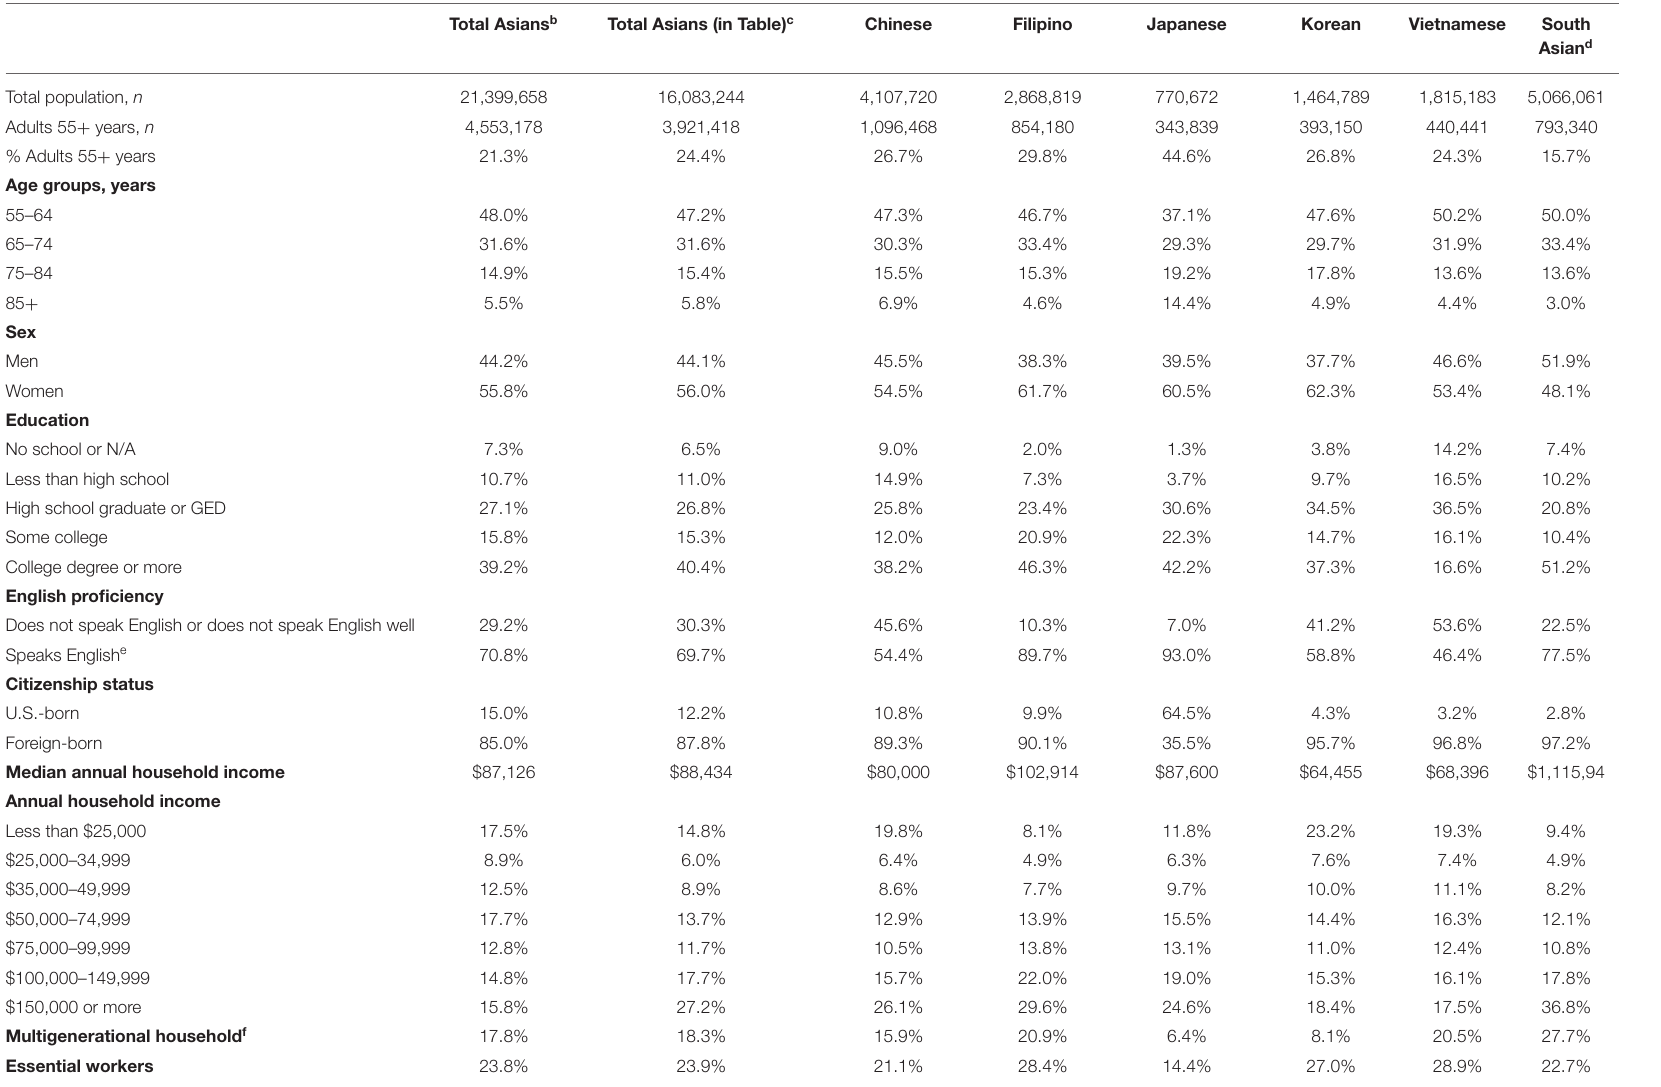
TABLE 1 | Characteristics of Asian American adults aged 55 years and over, American Community Survey 2015–2019 a